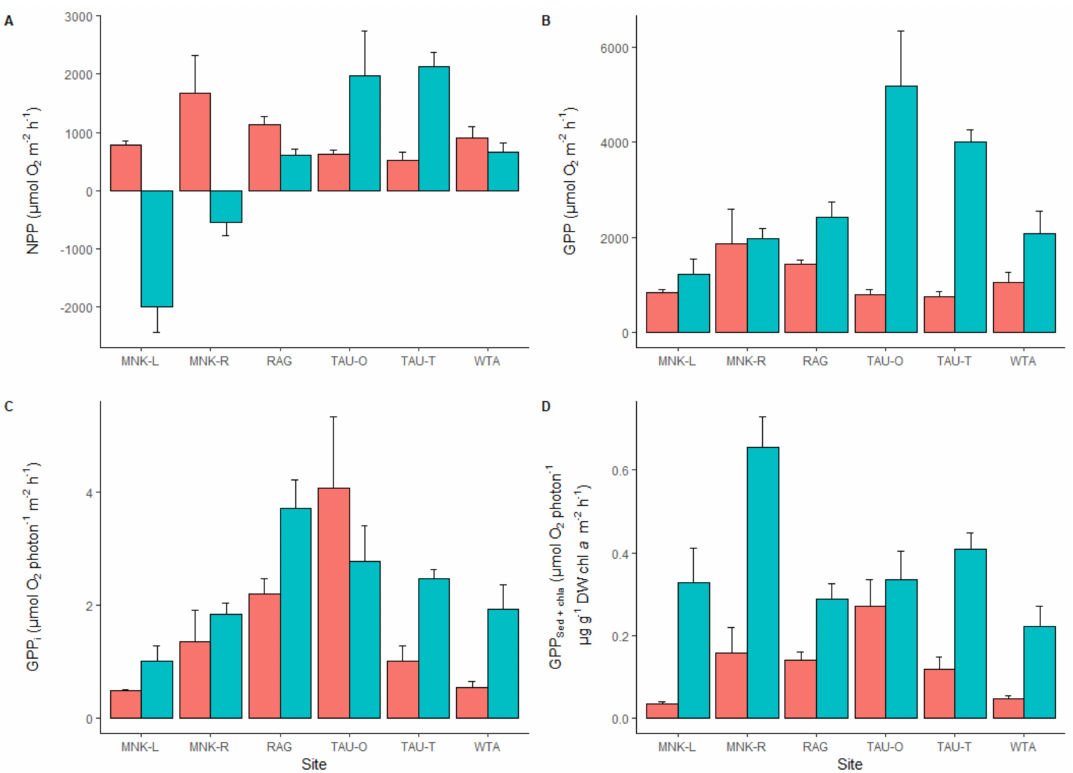
Figure 4. Net primary production (NPP) ( A ), gross primary production (GPP) ( B ), gross primary production corrected by PAR i (GPP i ) ( C ), and gross primary production corrected by PAR Sed and photosynthetic biomass (sediment chl a content) (GPP Sed + chla ) ( D ), during emerged (red) and submerged (blue) tidal conditions in November 2018 (T3). Bars represent means (n = 9) with standard error bars